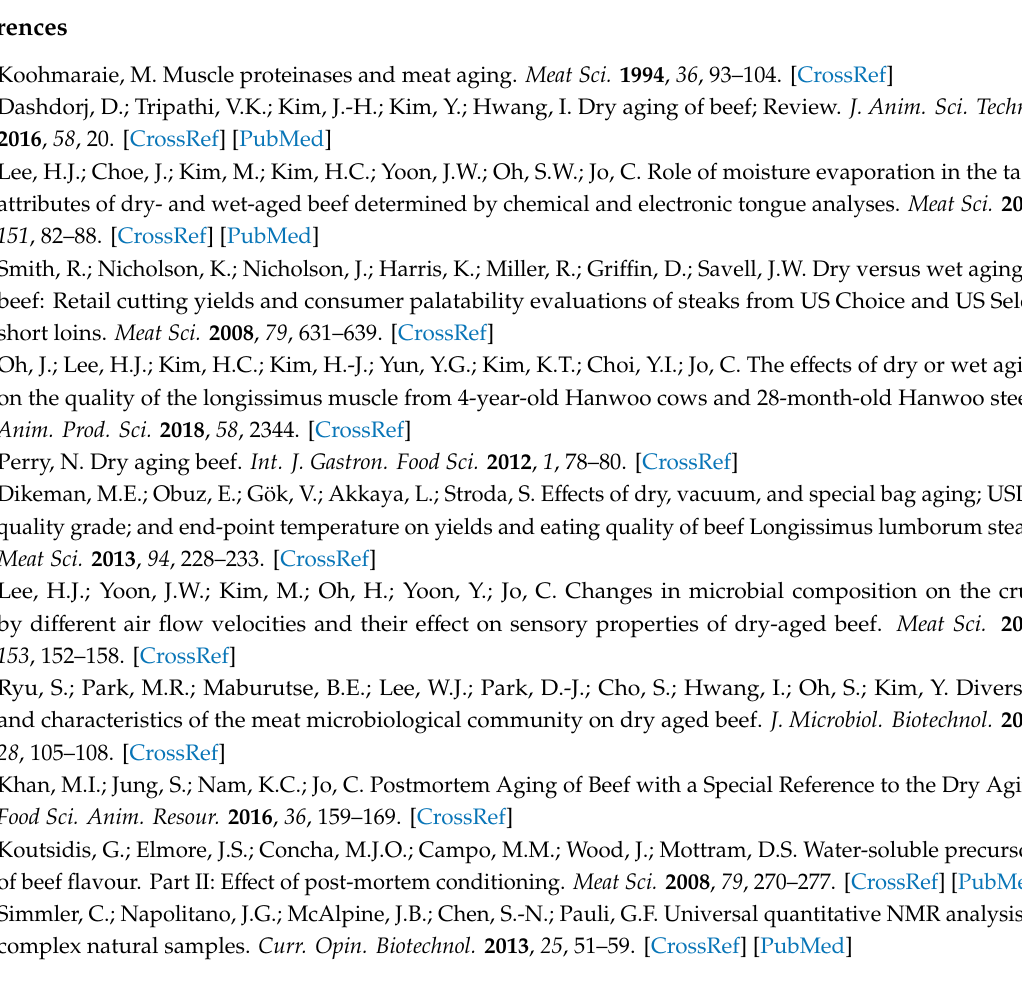
Supplementary Materials: The following are available online, Figure S1: Partial least square-discriminant analysis (PLS-DA) cross validation from quantified metabolites of beef aged by di ff erent method and crust. Validation was evaluated (a) overall groups, (b) dry- and wet-aged beef, (c) crust and dry-aged beef, and (d) crust and wet-aged beef, Figure S2: Representative 1 H- 13 C hetero nuclear single quantum coherence (HSQC) NMR spectrum from 28 day-aged crust of dry aging extracts acquired using a 850 MHz cryo-NMR spectrometer and metabolites list of pattern integration for 2D qNMR analysis, Figure S3: Standard curves of quantification from 1 H- 13 C hetero nuclear single quantum coherence (HSQC) based on the 1D 1 H quantitative NMR using a 850 MHz cryo-NMR